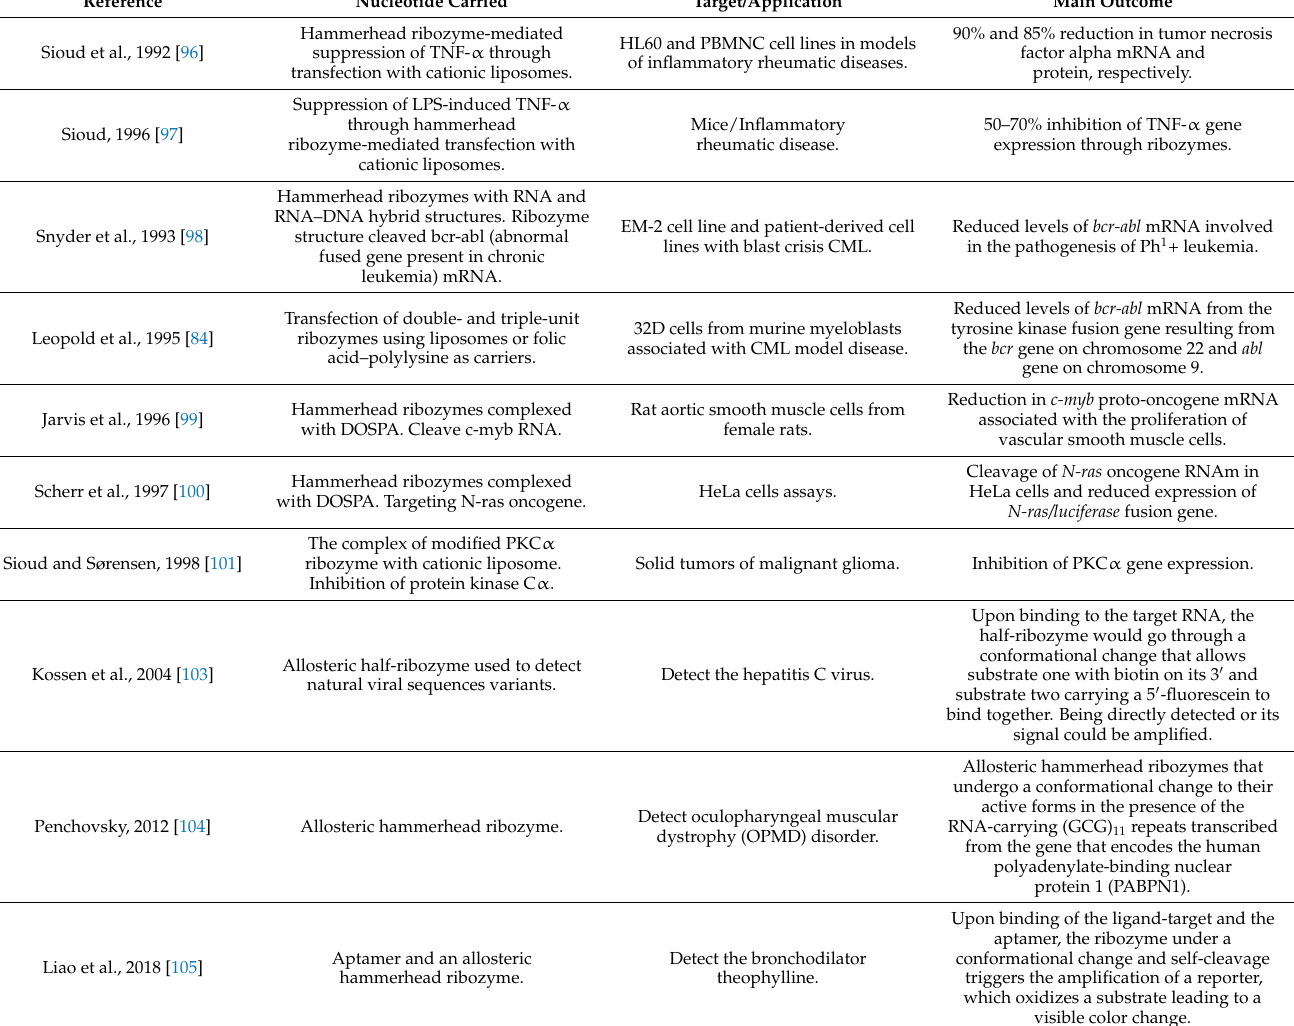
Table 3. Lipid-based ribozyme delivery systems for theranostic